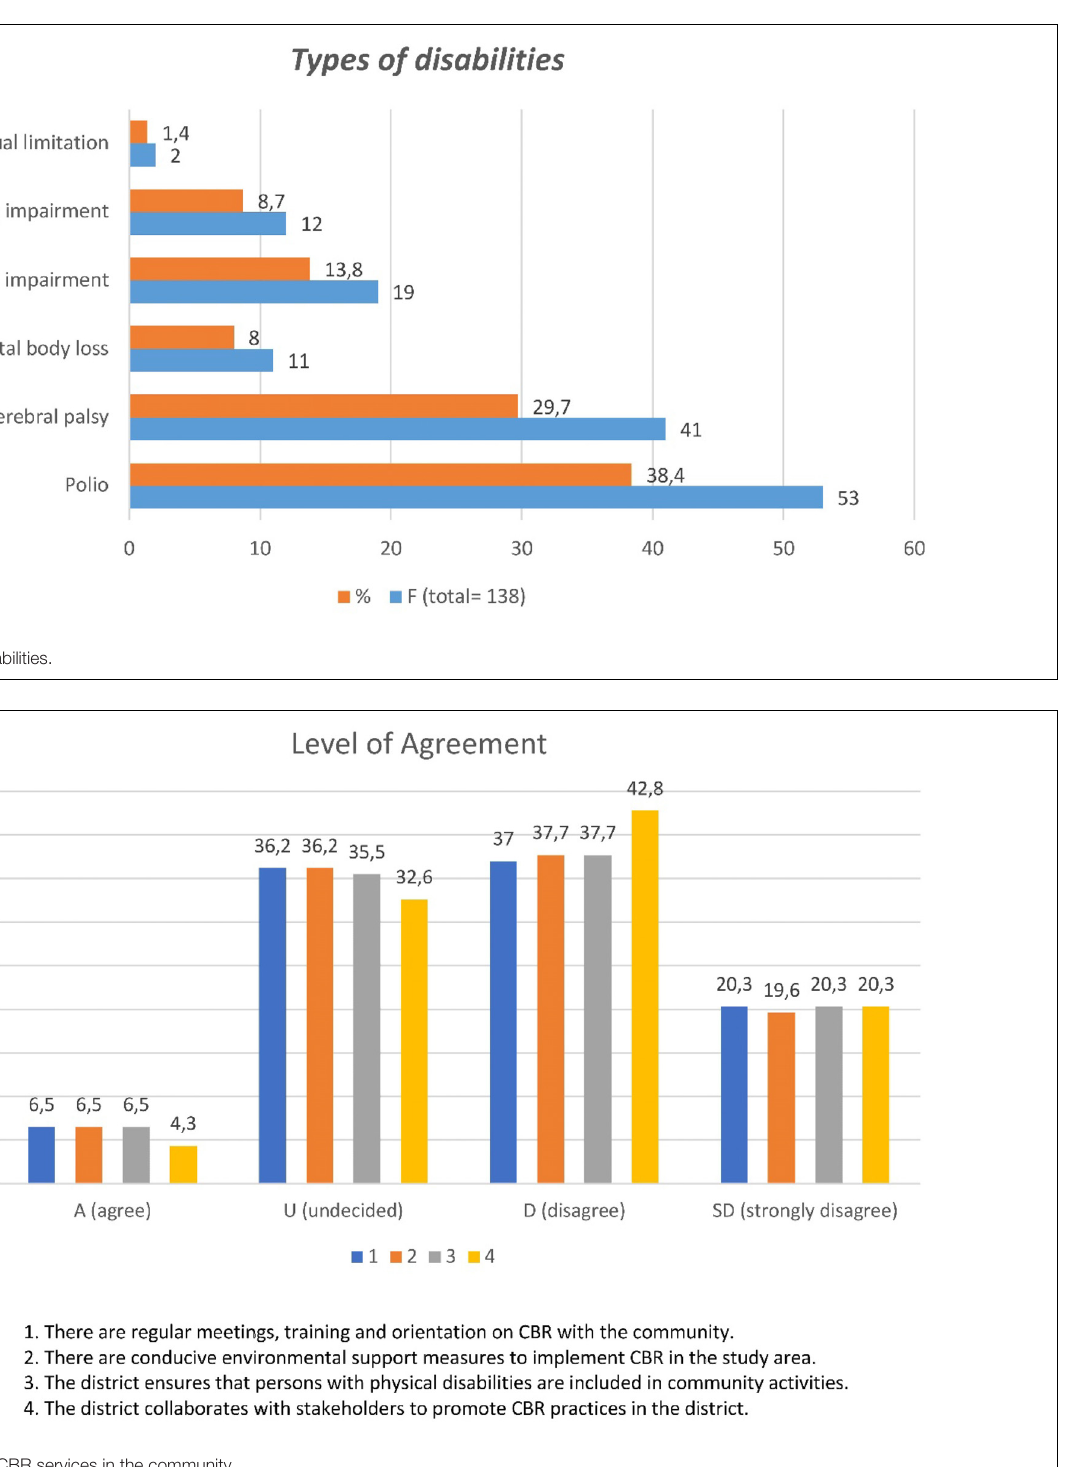
Major Findings of the Quantitative Study A five-point Likert scale (strongly agree to strongly disagree) was used to collect data. In the scale SA, strongly agree; A, agree; U, undecided; D, disagree; and SD, strongly